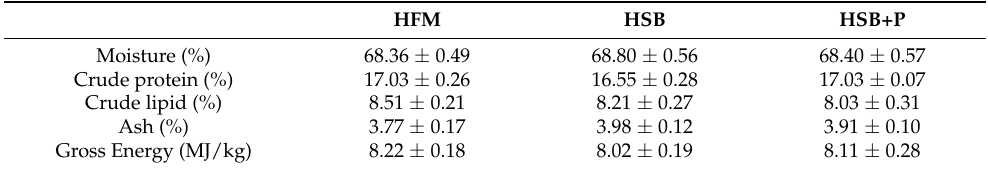
Table 4. Effects of experimental diets on whole body proximate composition of largemouth bass (Mean ± SEM, n =